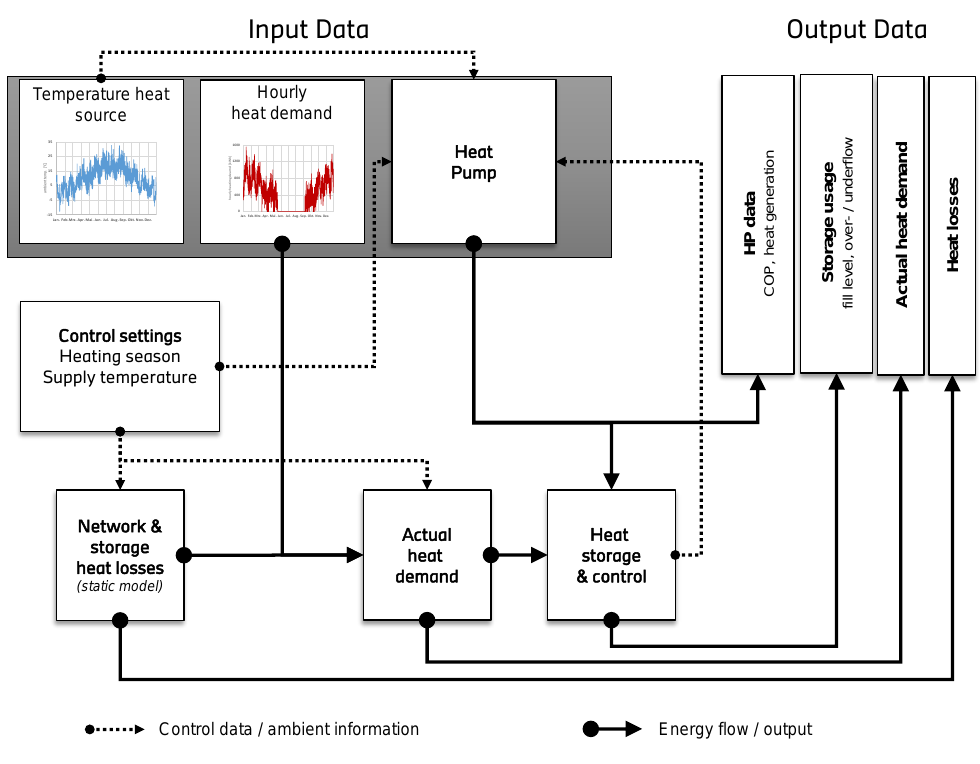
Figure 3. Structure of simplified INSEL HP simulation